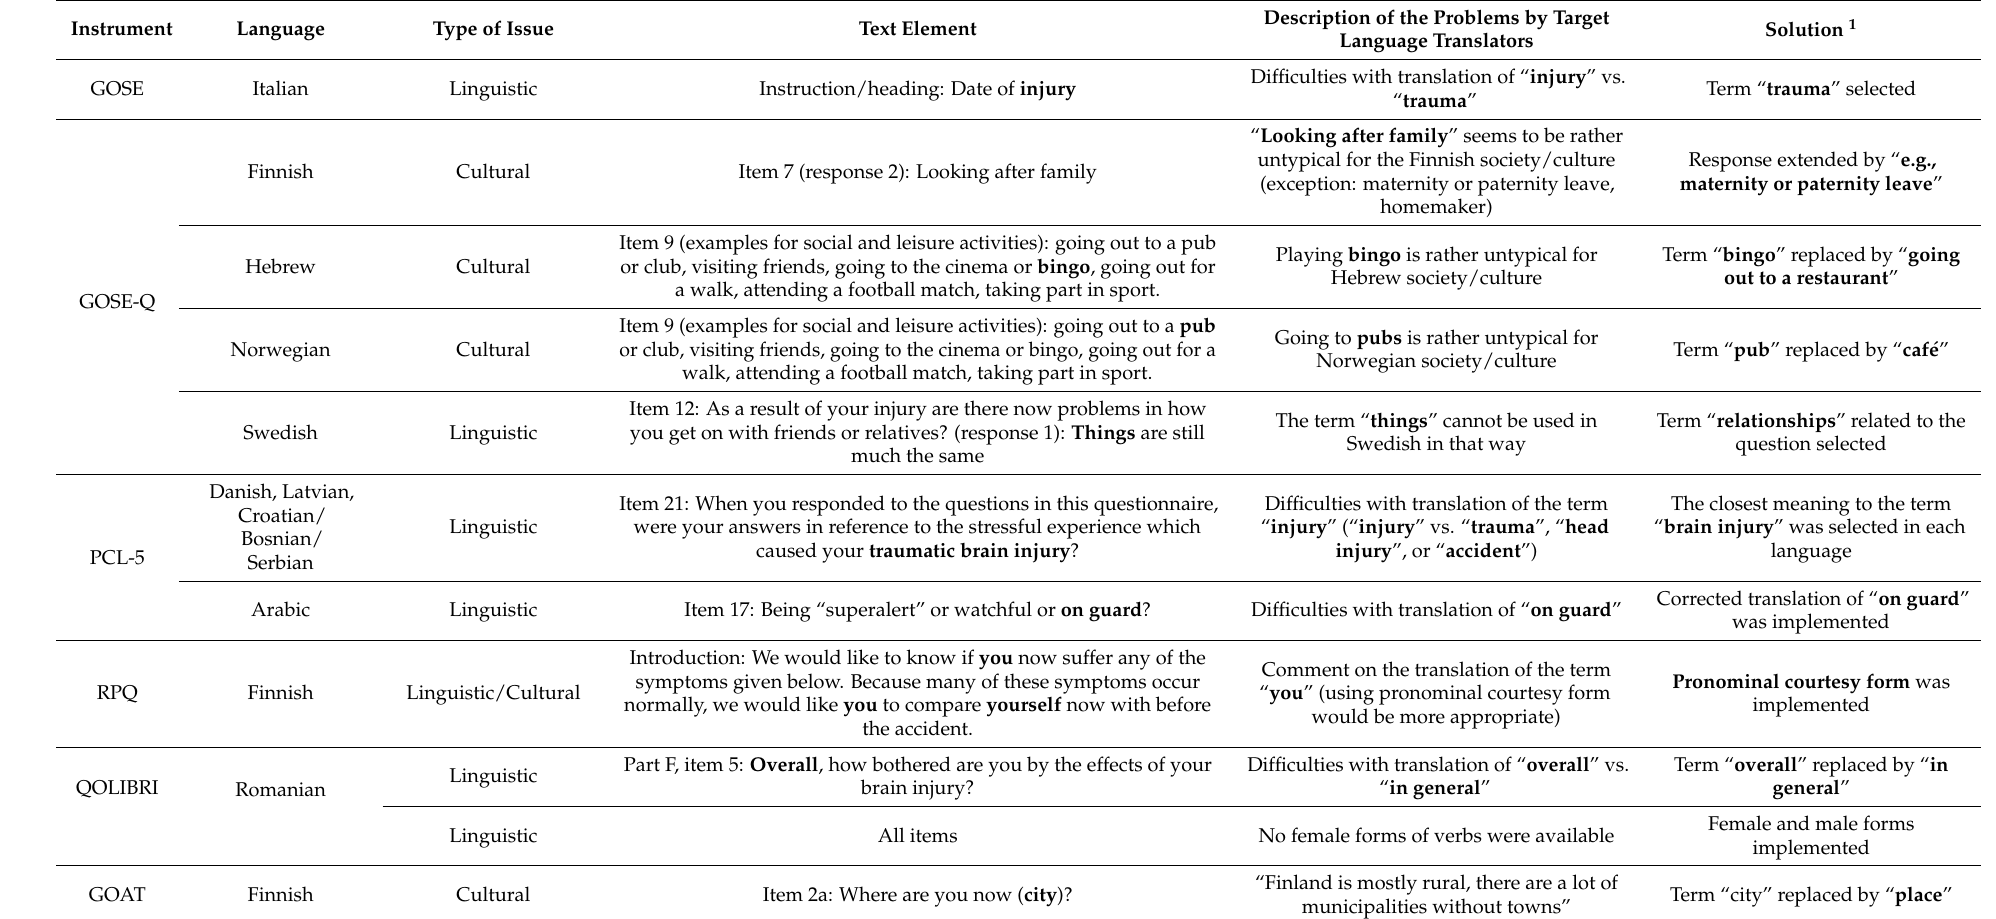
Table 7. Translational